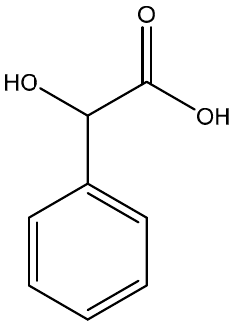
Figure 5. Illustrated structure of mandelic acid .